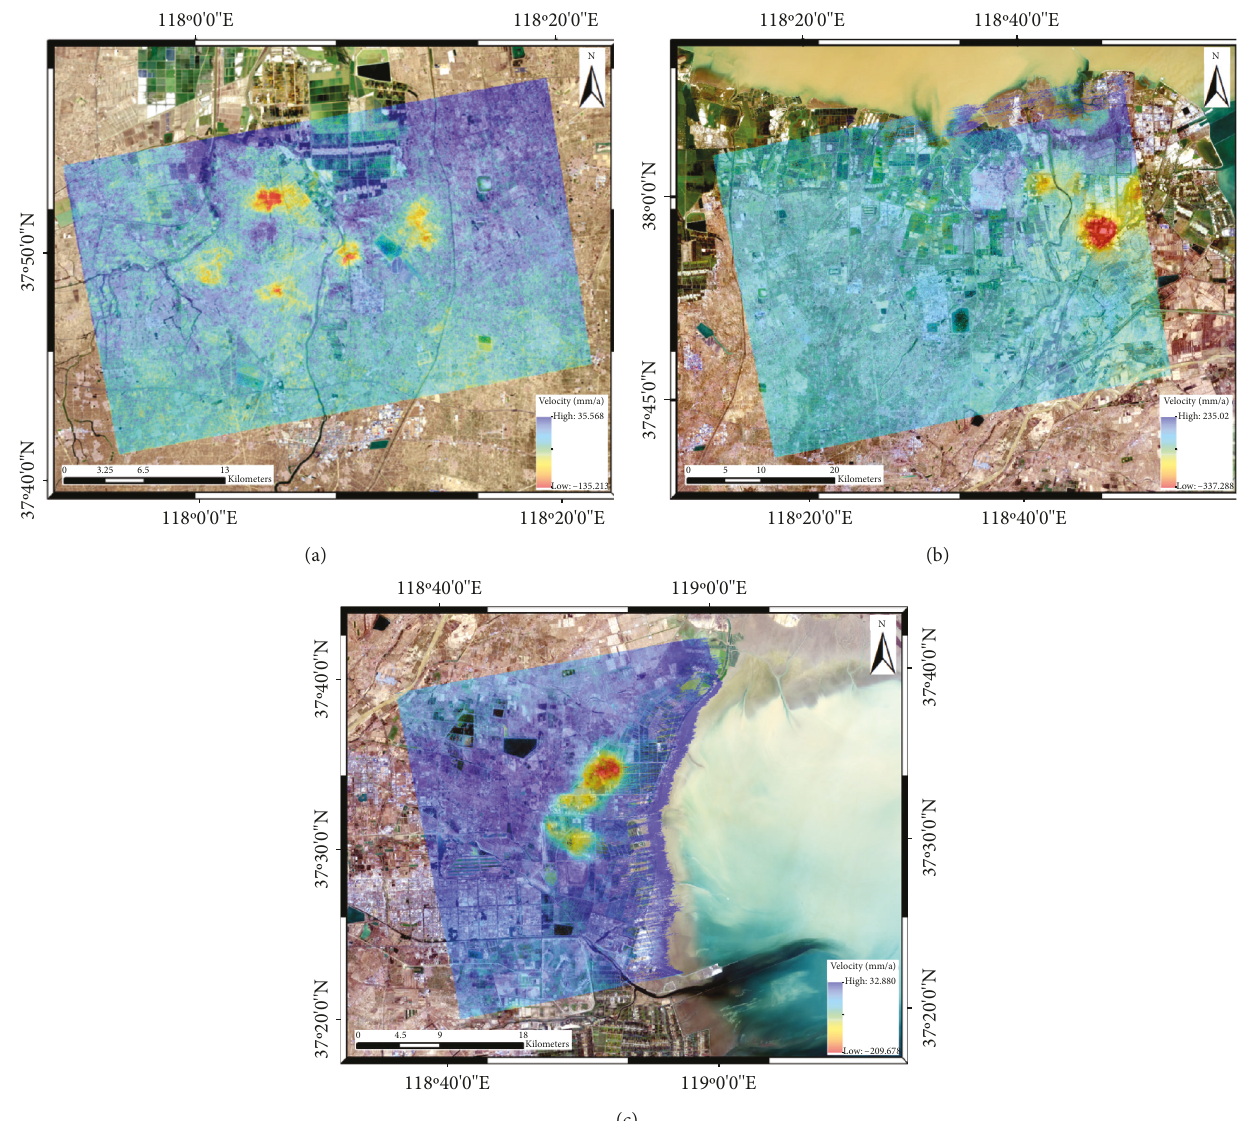
Figure 8: Subsidence rate results. (a) Subsidence rate of Zhanhua district ⑥ in Figure 5; (b) subsidence rate of Xianhe town ⑦ in Figure 5; (c) subsidence rate of Hongguang village ⑤ in Figure 5. Negative values indicate an increase in the distance along the LOS (subsidence) and positive values present a decrease in the distance along the LOS